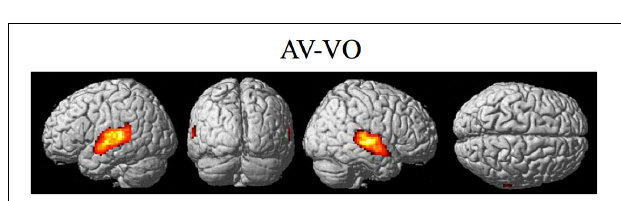
FIGURE 7 | Significant brain activity for the contrast of the combined AV conditions relative to the visual only VO condition thresholded at pFDR < 0.05 corrected. Activity was present in the left and right superior temporal gyrus/sulcus including primary and secondary auditory